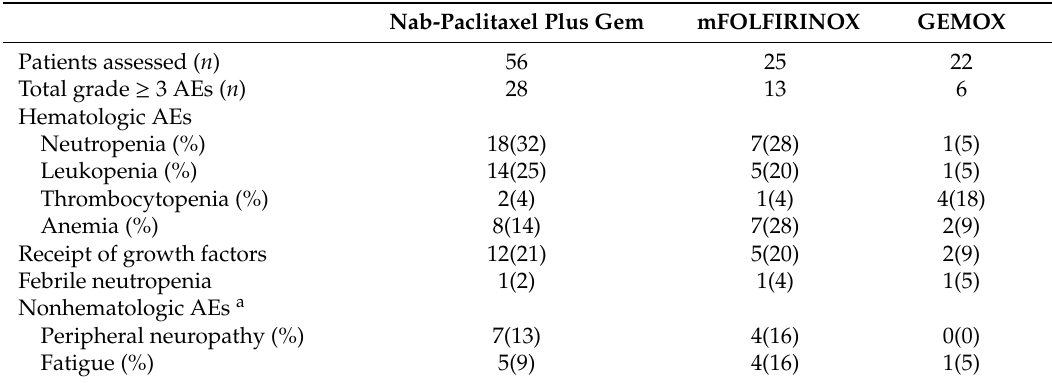
Table 4. Grade ≥ 3 treatment-emergent adverse events of three subgroups with di ff erent regimens inpatients with unresectable pancreatic